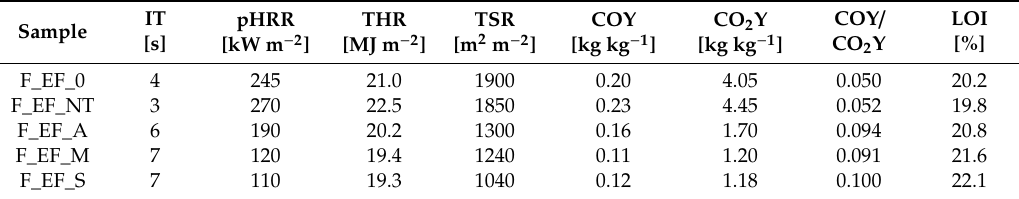
Table 6. Characteristic parameters describing the flammability of polyurethane